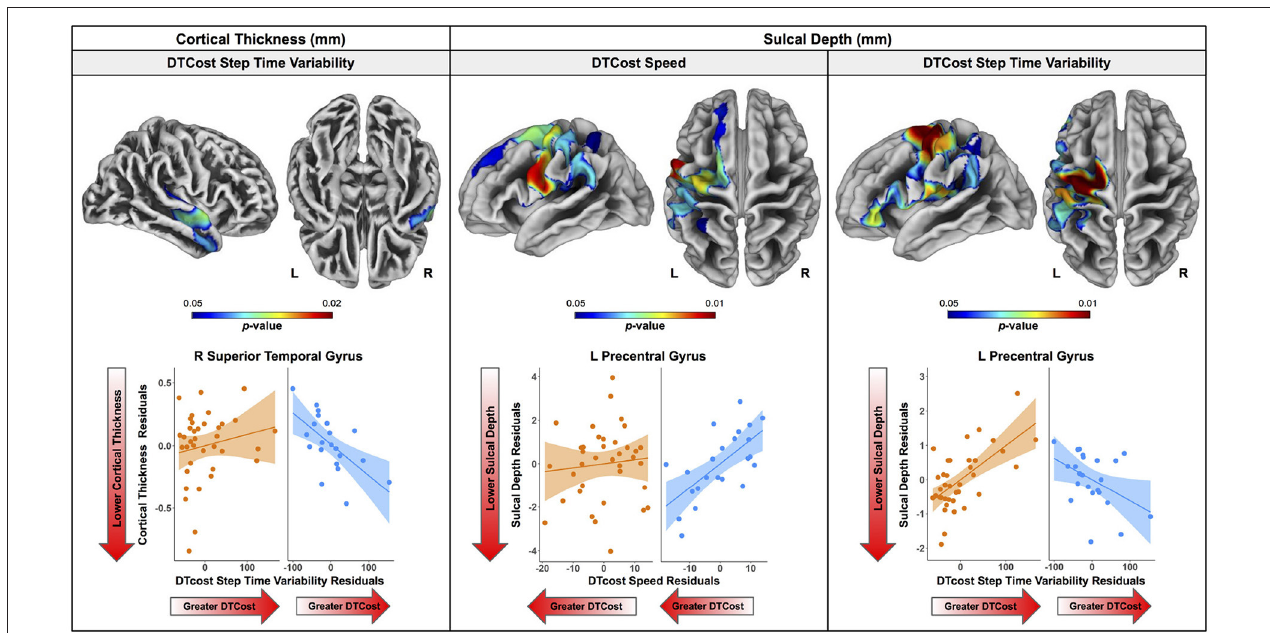
FIGURE 6 | Age differences in the relationship of surface metrics with the DTcost of gait. Top. Regions showing statistically significant ( p FWE − corr < 0.05) age group differences in the relationship of cortical thickness (left) and sulcal depth (middle, right) with the DTcost of gait speed and step time variability. Warmer colors indicate regions of greater age differences in brain-behavior correlations. Results are overlaid onto CAT12 standard space templates. L = left; R = right. Bottom. Surface values for the peak result coordinate for each model are plotted against DTcost of gait to illustrate examples of the relationships identified by the voxelwise statistical tests. The fit line and confidence interval shading are included only to aid visualization of these relationships. We plotted the residuals instead of the raw values here to adjust for the effects of the sex covariate included in each model.